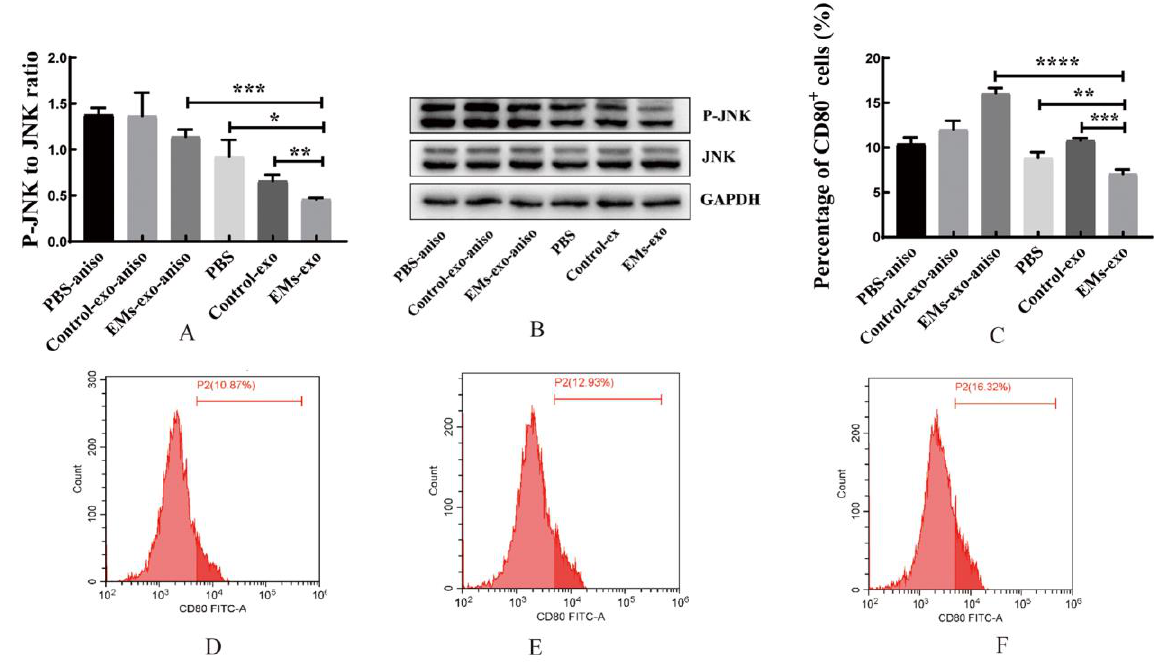
Figure 5. Exosomes of the EMs group decreased the expression of P-JNK in macrophages. ( A , B ) West- ern blot was used to verify the expression of P-JNK in macrophages. ( C ) The flow cytometry was used to detect the proportion of CD80 + macrophages. ( D ) The effects of PBS on the proportion of CD80 + macrophages after adding anisomycin. ( E ) After adding anisomycin, the effects of exosomes from the control group on the proportion of CD80 + macrophages. ( F ) After adding anisomycin, the effects of exosomes from the EMs group on the proportion of CD80 + macrophages. JNK activator: anisomycin (aniso). Data are expressed as the mean ± SEM (* p < 0.05, ** p < 0.01, *** p < 0.001, **** p < 0.0001).